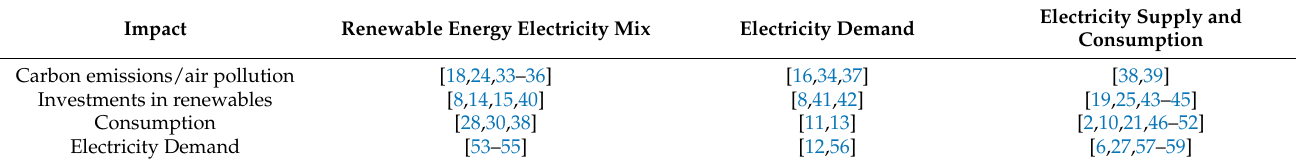
Table 2. Study categorization by application and impact areas.